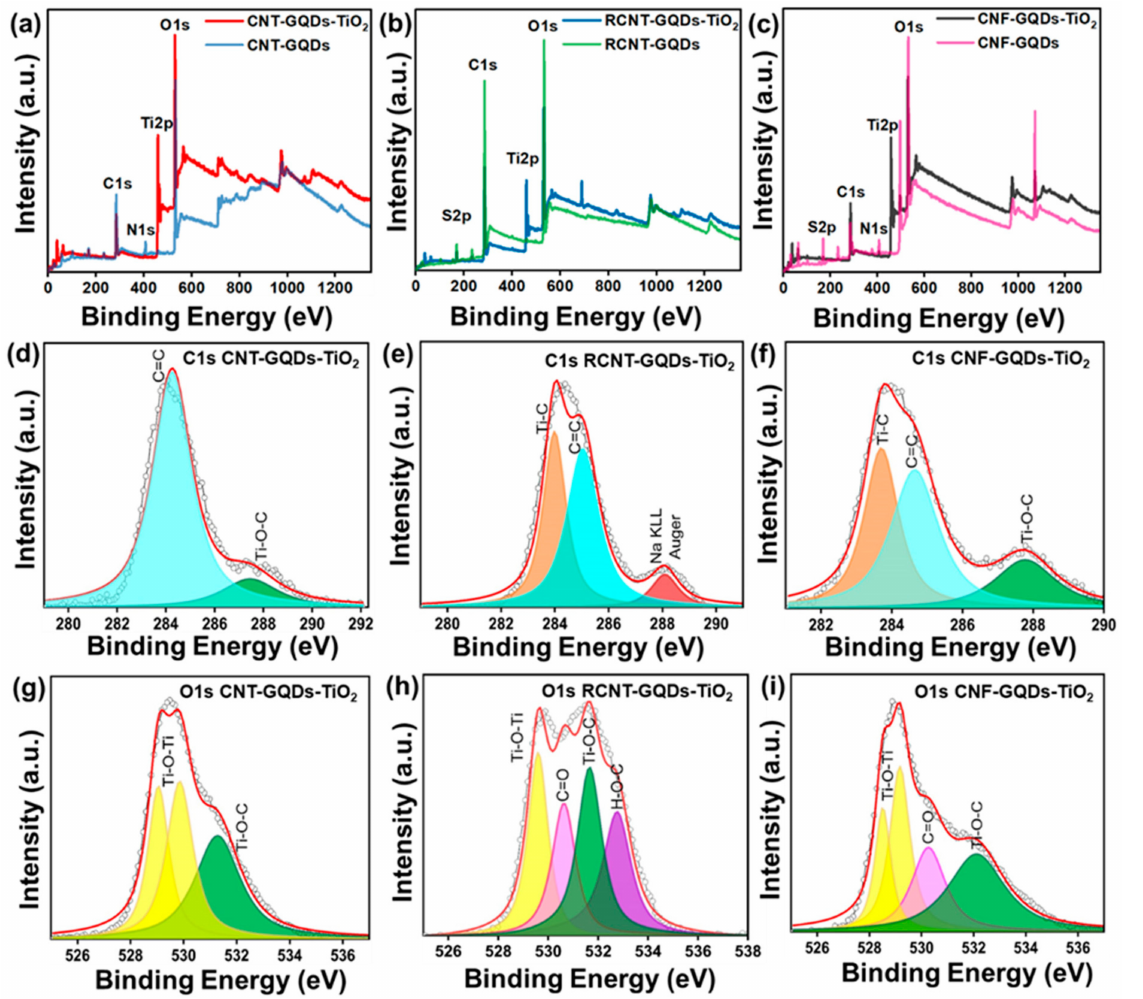
Figure 3. Synoptic XPS survey scan of ( a ) CNT-GQDs and CNT-GQDs-TiO 2 nanocomposites, ( b ) RCNT-GQDs and RCNT-GQDs-TiO 2 nanocomposites, ( c ) CNF-GQDs and CNF-GQDs-TiO 2 nanocomposites. High resolution XPS spectra of C1s peak ( d ) CNT-GQDs-TiO 2 , ( e )